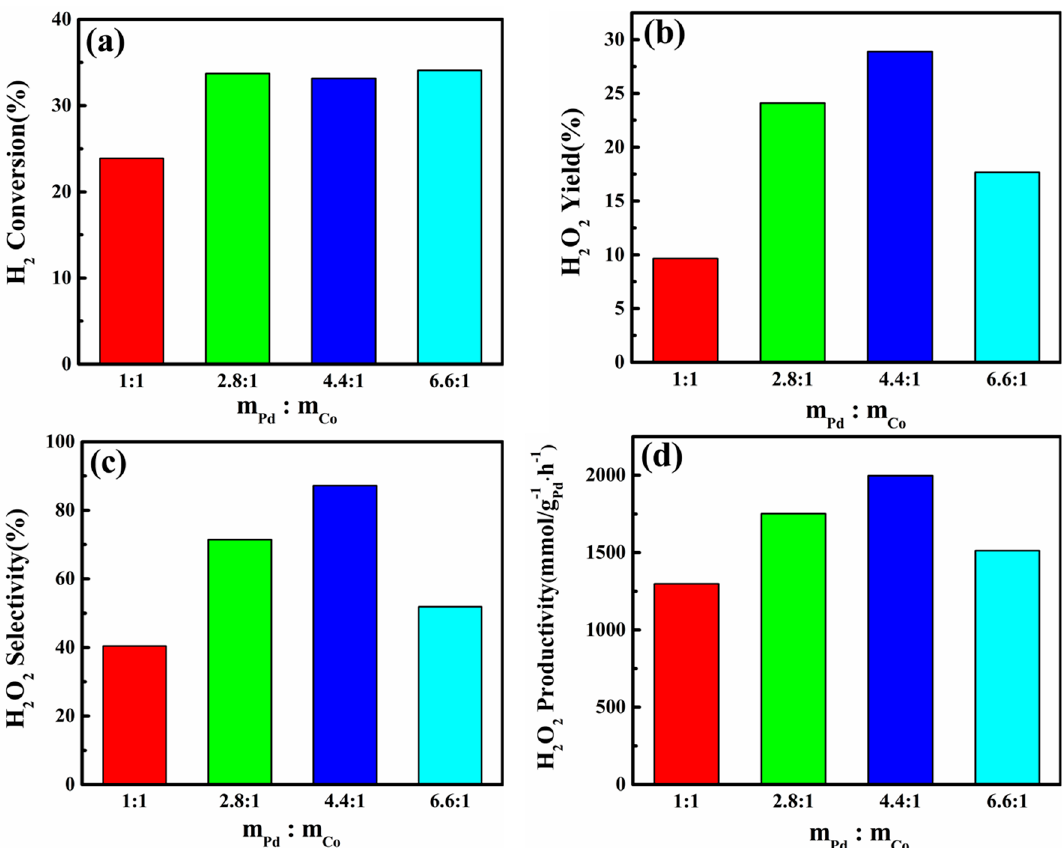
Figure 7. Catalytic activity of Pd-Co@HCS-(X) (= 1, 2.8, 4.4 and 6.6). ( a ) H 2 conversion, ( b ) H 2 O 2 yield,